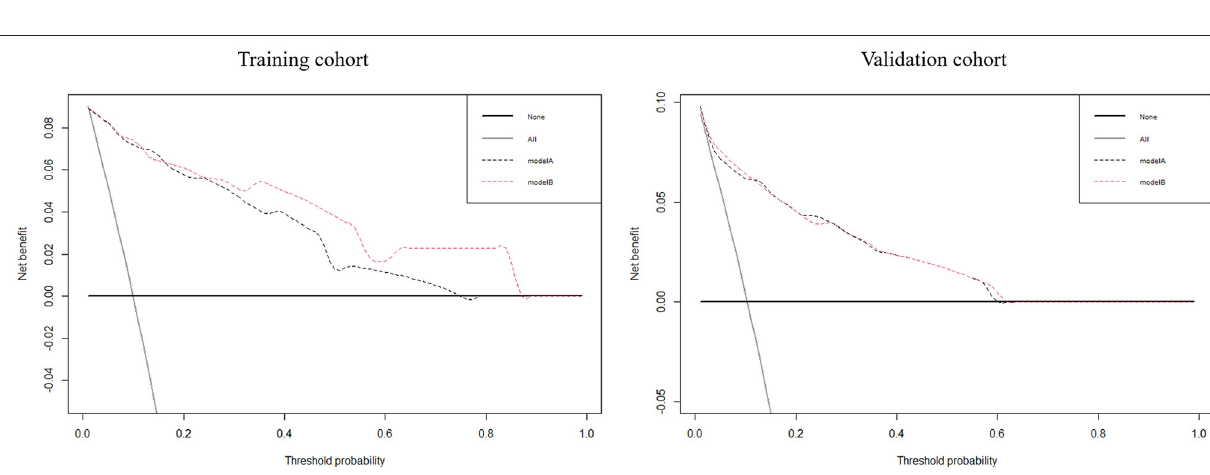
FIGURE 3 | The decision curve analyses for the two models to predict the occurrence of postoperative tracheostomy in aneurysmal subarachnoid hemorrhage patients in the training and validation cohorts.